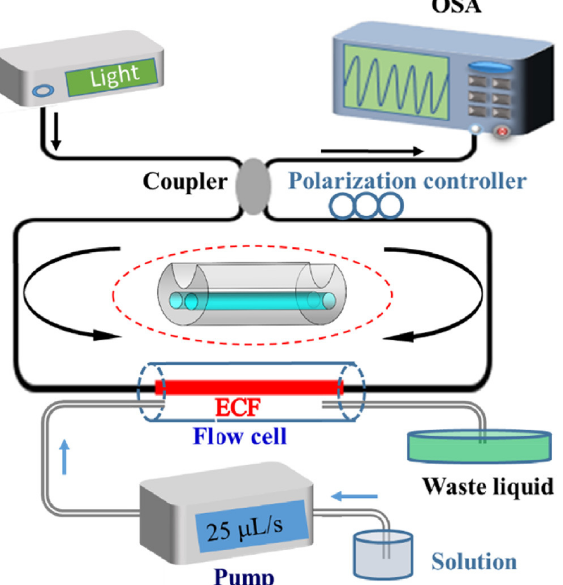
Figure 6. Schematic diagram of the proposed sensing system [44]. Reprinted with permission from Ref. [44]. Copyright 2018 Elsvier Science and Technology